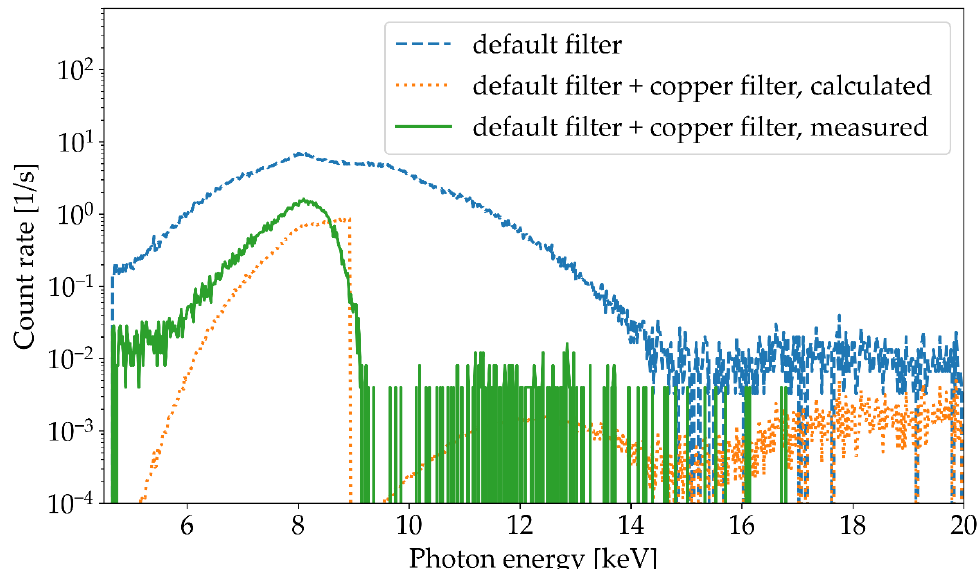
Figure 6. Pulse height spectra measured with the Amptek X-123 CdTe spectrometer during tungsten flat surface processing using a laser pulse energy of 550 µ J, a repetition rate of 400 kHz, a pulse duration of 1 ps, and a focus diameter of 10 µ m. Shown are the measured spectra without any additional copper filter (blue curve) and with a copper filter (green curve), as well as the calculated spectrum based on the convolution of the spectrum without copper filter with the transmission function of 50 µ m copper (orange